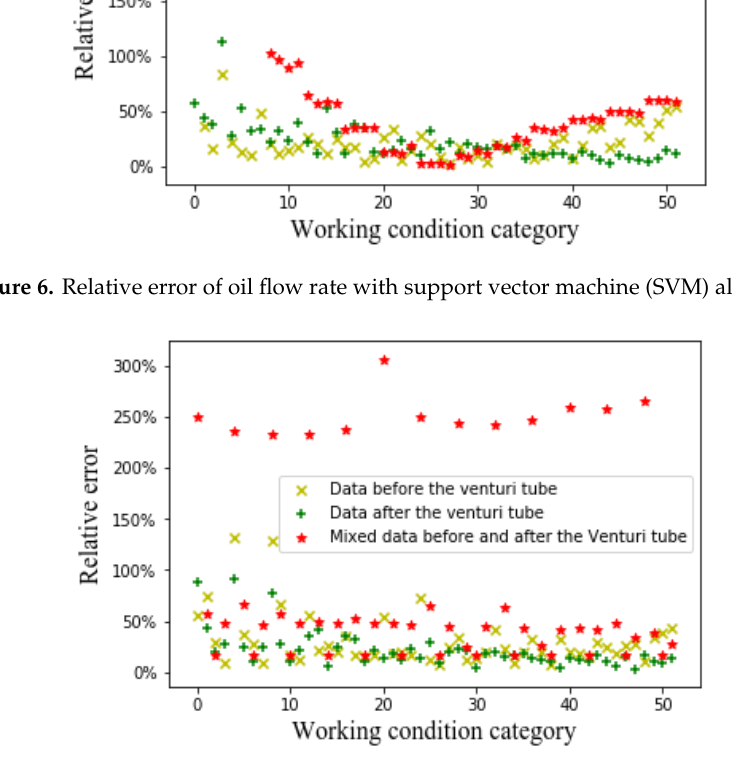
Figure 7. Relative error of gas flow rate with the SVM algorithm.